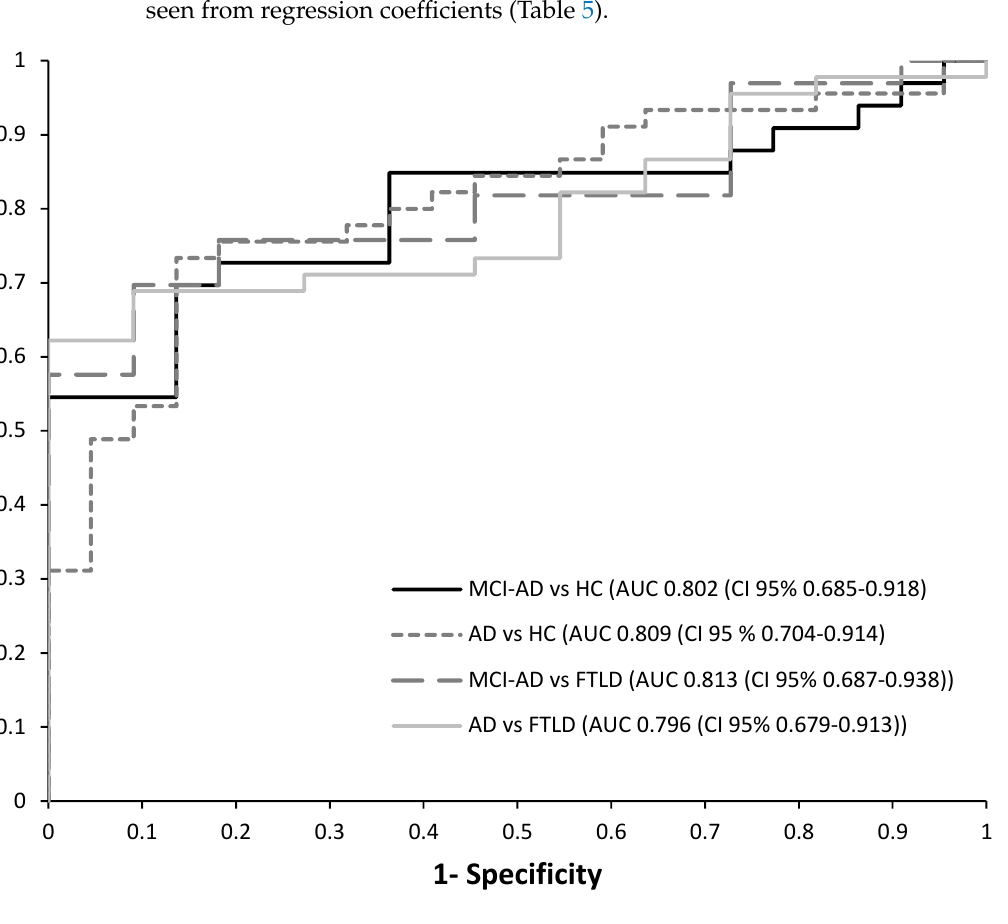
Figure 2. Receiver operating characteristic (ROC) curves for the PLS models developed from plasma biomarkers levels. (1) HC vs. MCI-AD; (2) HC vs. AD (MCI-AD + dementia-AD); (3) MCI-AD vs. FTLD; (4) AD (dementia-AD + MCI-AD) vs. FTLD. Table 5. Regression coefficients for the variables in each PLS model.